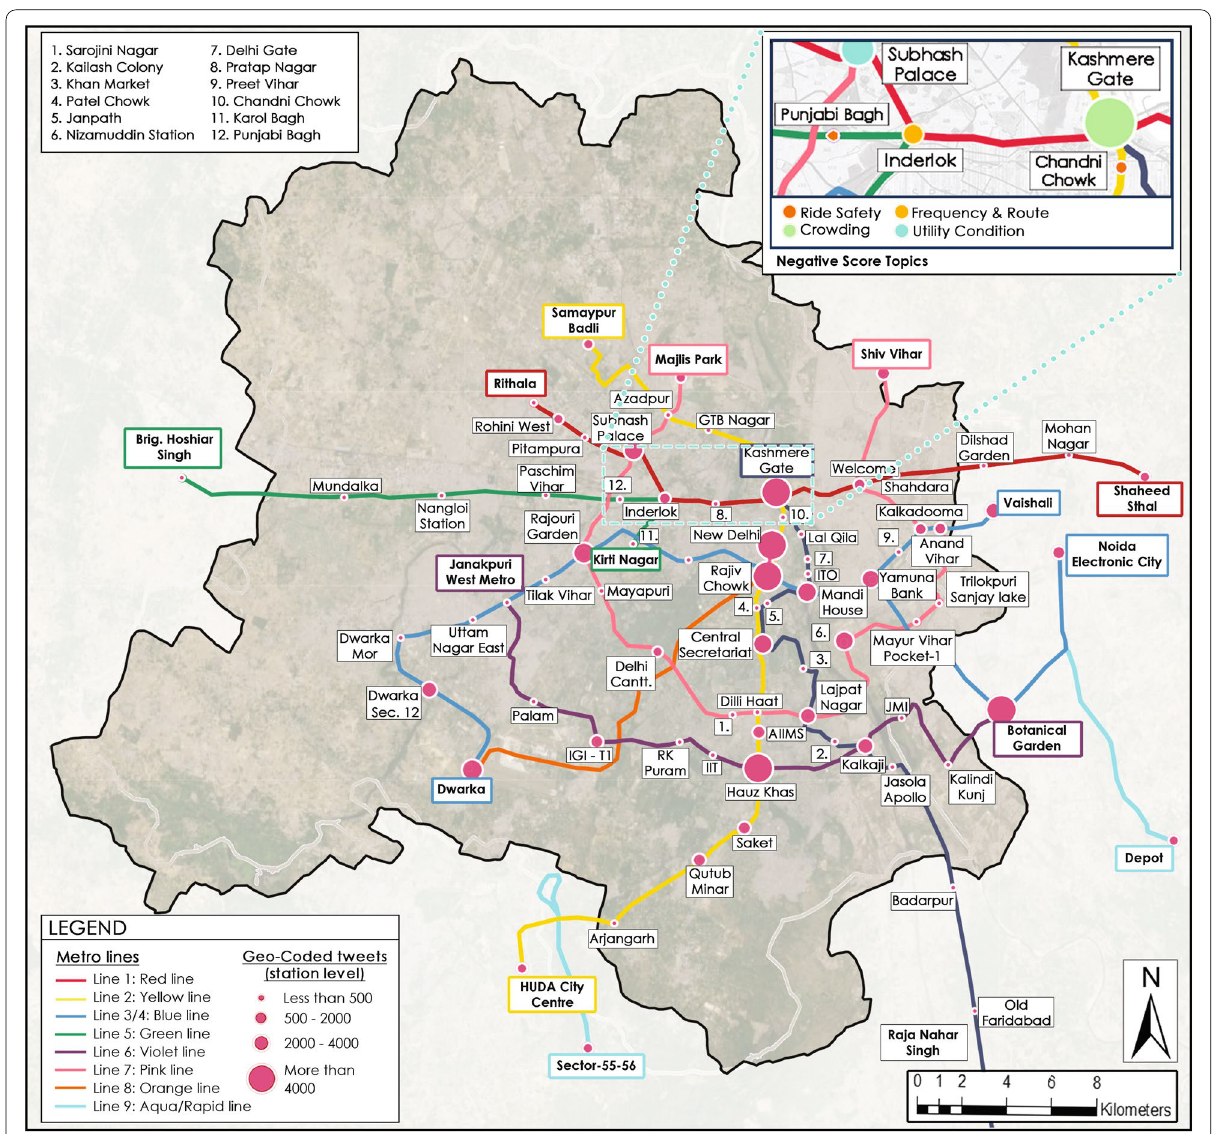
Fig. 7 Geocoded tweets at station level. Source: